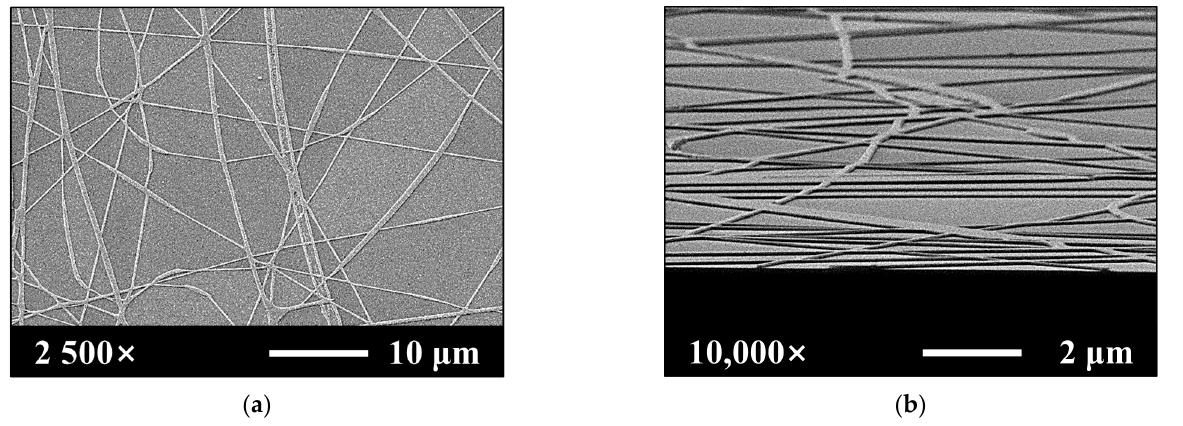
Figure 2. ( a ) Top view and ( b ) tilted view SEM images of the SiNWs after transferring the pattern template of the PVP NFs to the uppermost Si layer of the SOI wafer.